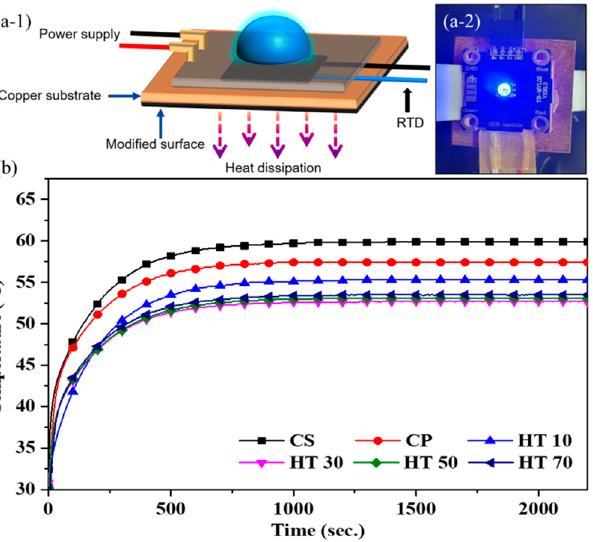
Figure 6. ( a-1 ) Schematic and ( a-2 ) photo of test setup with LED module and heat sink. ( b ) Temperature of LED module assembled to a heat sink with copper surface (CS) and electrodeposited copper surface (EC) with heat treatment for 10 min (HT10), 30 min (HT30), 50 min (HT50), and 70 min (HT70).